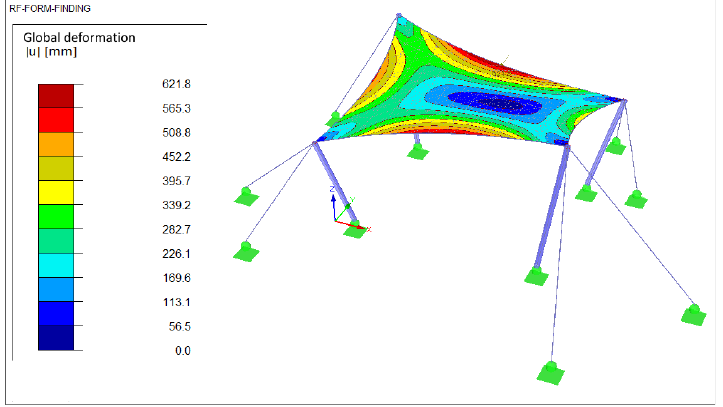
Figure 3. Initial model and location of supports [30].